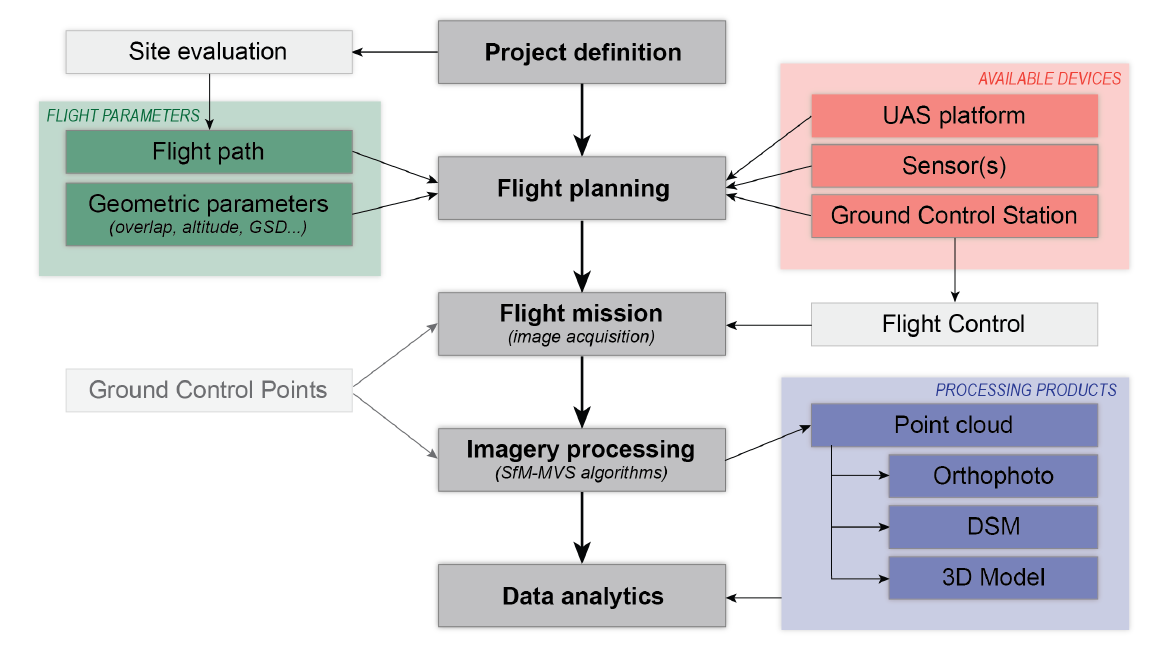
Figure 16. Typical acquisition and processing pipeline for RGB imagery with the use of SfM-MVS